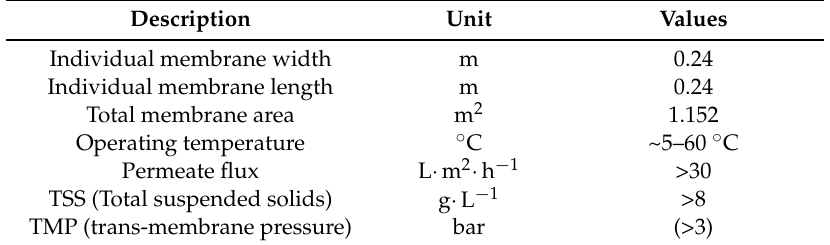
Figure 3. Static square-shaped membrane bioreactor (MBR) system in operation. The square membrane module is located in the larger tank on the right for filtration purposes. Table 1. Dimensions and operating conditions of the square-shaped Flexidisks MBR module.